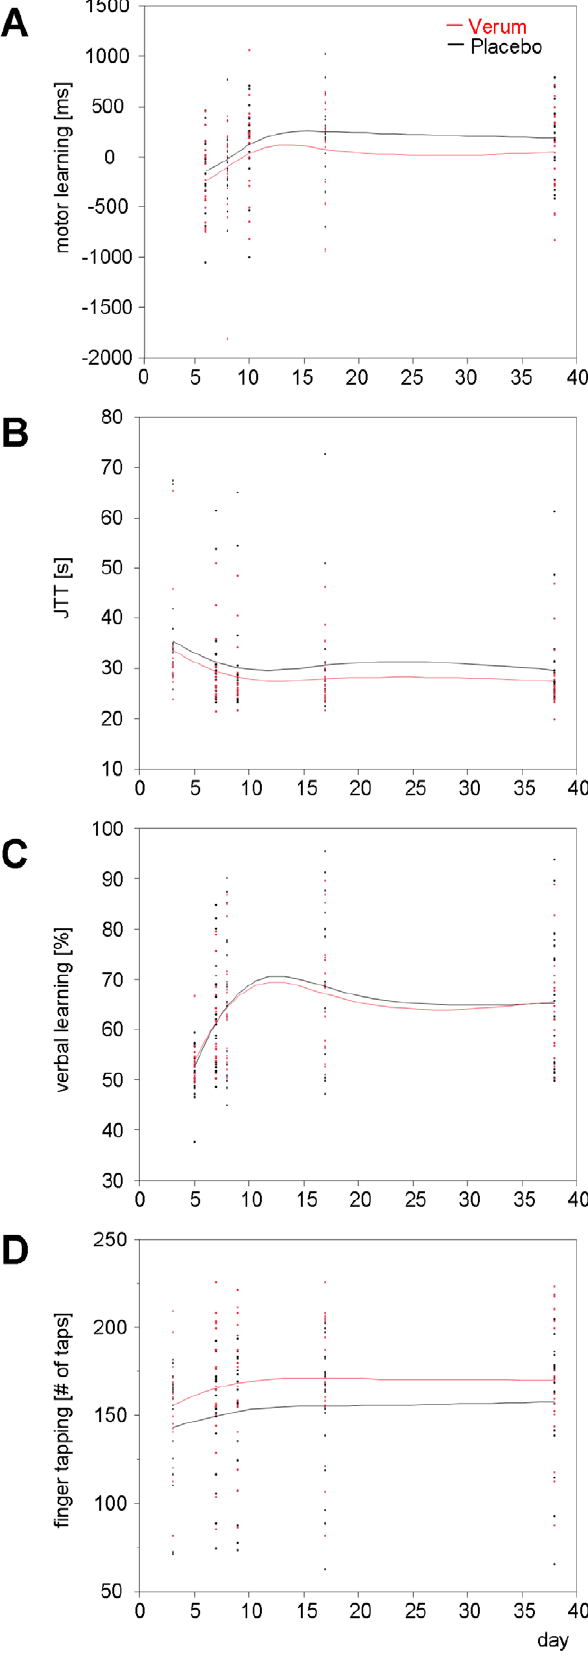
Figure 4. Exploratory efficacy outcome measures. a, motor learning task: Magnitude of learning is reflected by the difference in reaction times between random and sequential elements [ms]. B, Jebsen Taylor Test of hand function: Performance in this test was reflected by total time needed to complete the six subtests [s]. c, verbal learning task: Magnitude of learning is reflected by the [percentage] of correct responses (words learned). D, finger tapping speed: Perfor- mance in this test was reflected by the [number of key presses] within the time interval. Curves were fitted using a cubic spline function with a lambda of